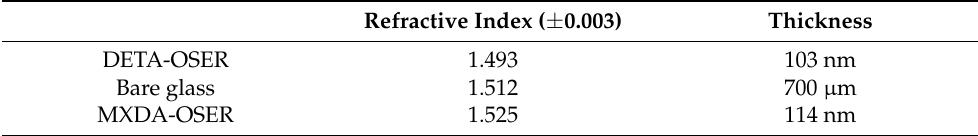
Figure 6. Transmittance spectra of the DETA-OSER, MXDA-OSER and bare glass. Table 2. Refractive index and thickness of the DETA-OSER, MXDA-OSER and bare glass. Refractive Index ( ±